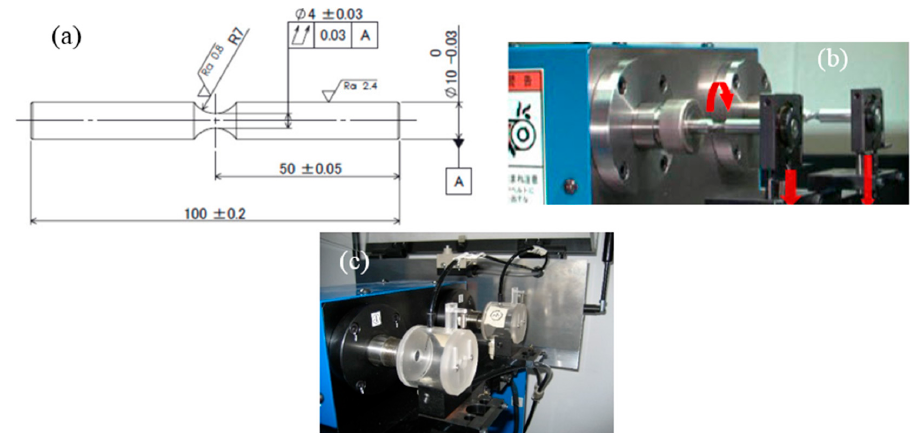
Figure 1. Schematic drawing of rotating bending fatigue specimen. ( a ) Size and shape of sample; ( b ) rotation bending applied to schematic drawing in the air case; ( c ) environmental box for the corrosion liquid dropping.